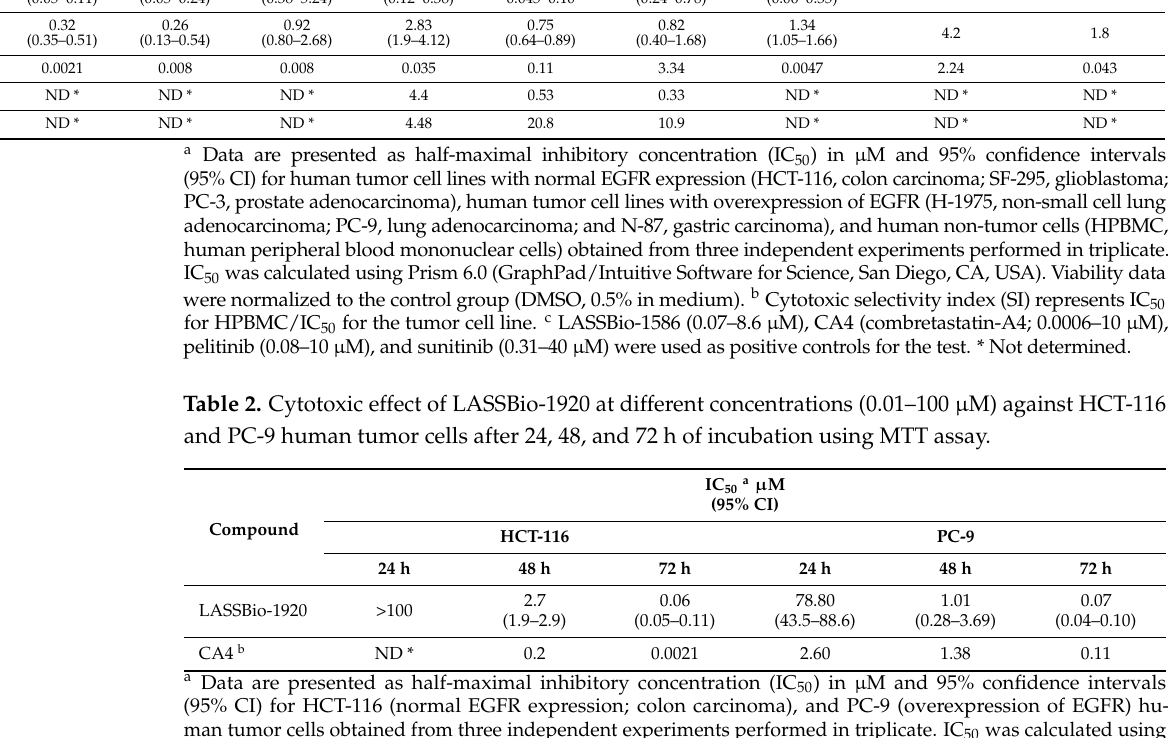
Table 1. Cytotoxic effect of LASSBio-1920 at different concentrations (0.02–2.5 µ M) against human tumor cell lines and human non-tumor cells after 72 h of incubation using MTT assay. Compound